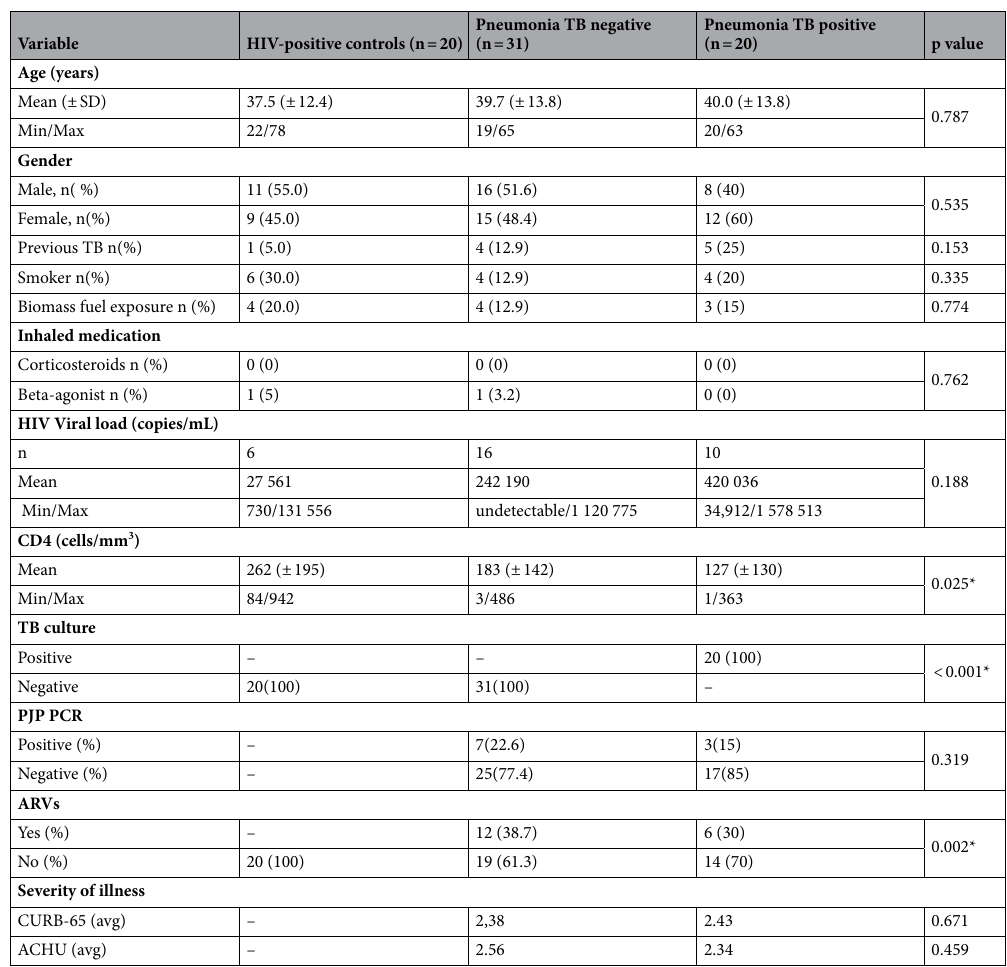
Table 1. Baseline characteristics of participants enrolled in the study. *Statistically